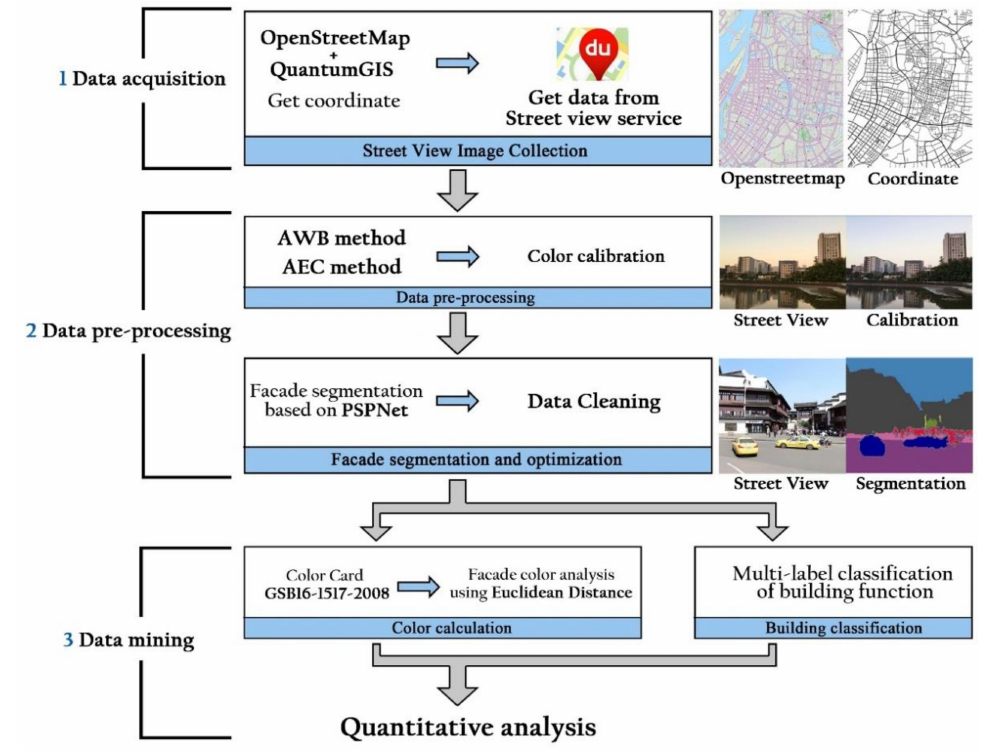
Figure 1. Workflow for façade color measurement with building